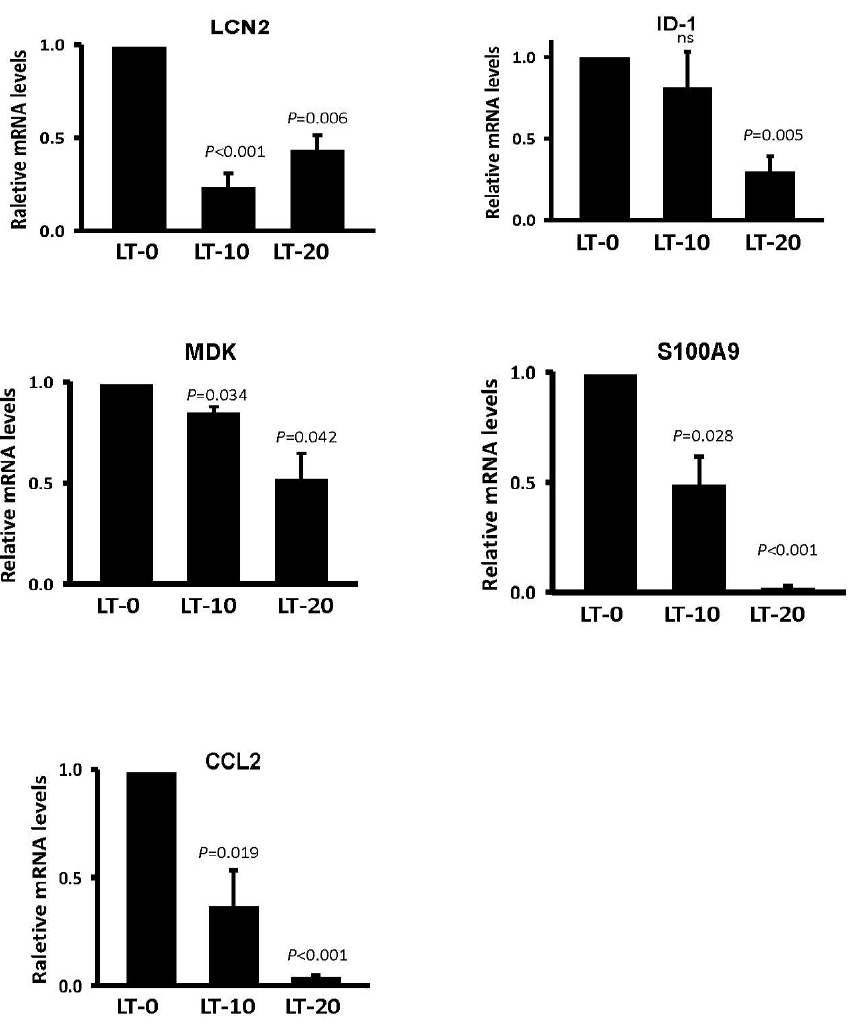
Figure 4. Five migration-related genes were validated in long-term Oro-A-exposed OSCC cells. The mRNA levels of LCN2, ID-1, MDK, S100A9, and CCL2 were determined by Q-PCR. Beta-2-microglobulin ( β 2M) was used as the internal control. All experiments were performed at least three times. P values were determined using Student’s t test. Ns: not significant. Table 1. Top 10 downregulated migration-related candidate genes in cells with long-term Oro-A exposure.